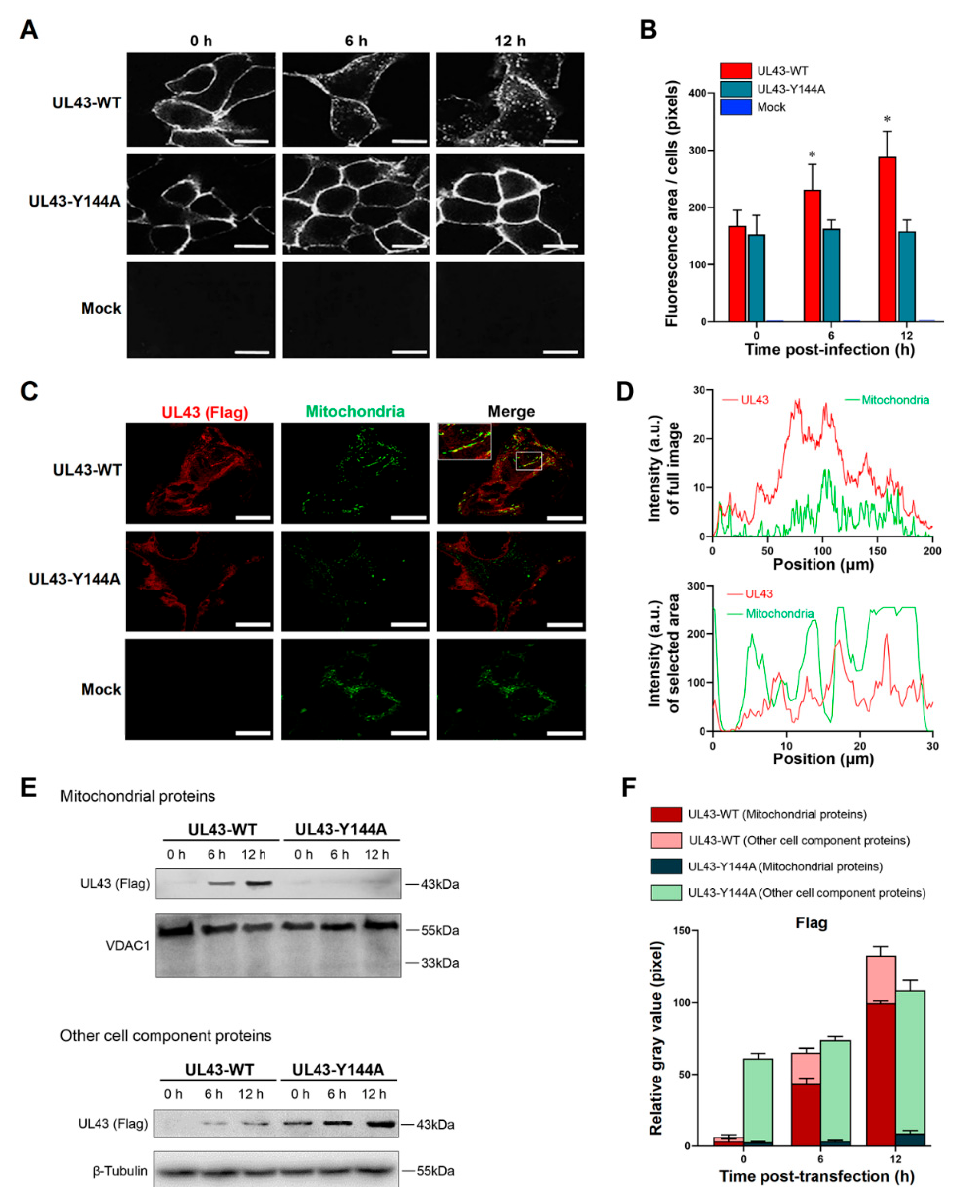
Figure 3. Internalization and localization of the HSV-1 UL43 protein to mitochondria. ( A ) Fluorescent image of UL43 protein internalization at 0, 6 and 12 h after transfection. ( B ) Quantitative analysis of average fluorescence areas of cells, *: p < 0.05 vs. other groups. ( C ) Co-fluorescent image of UL43 protein and mitochondria at 12 h after transfection. UL43-FLAG protein (red), mitochondria (green). ( D ). Fluorescence intensity analysis of UL-WT, both full-size image and mitochondrial region. ( E ) Western blot analysis of UL43-FLAG expression in mitochondria and other cell components, at 0, 6 and 12 h after transfection. ( F ) Relative quantitative analysis of UL43 FLAGs expression in mitochondria and other cell components. Scale bar = 5 µ m. Groups: UL43-WT (pCMV(f)UL43-WT plasmid), UL43-Y144A (pCMV(f)UL43-Y144A plasmid), Mock (empty